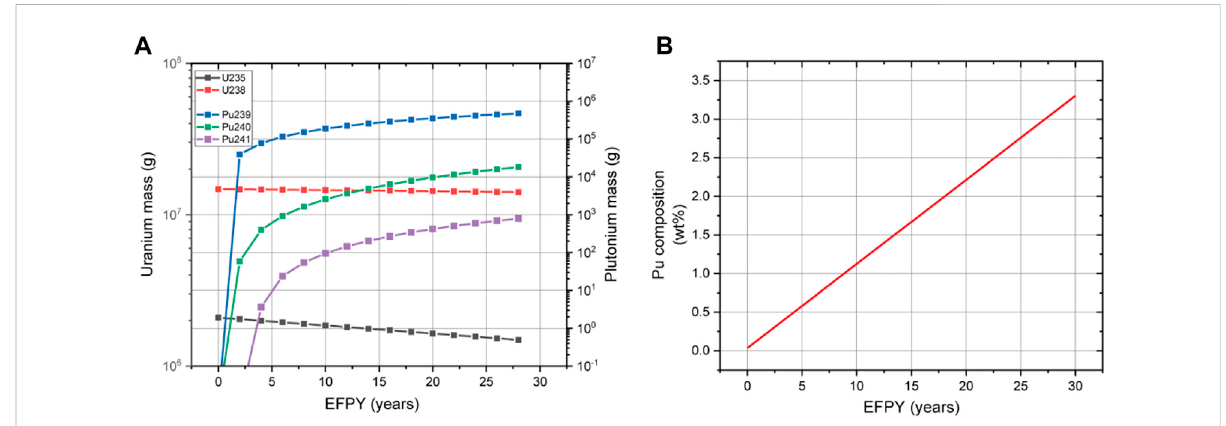
FIGURE 1 (A) Mass variation pro fi les of U and Pu isotopes and (B) composition pro fi le of plutonium (Nguyen et al.,